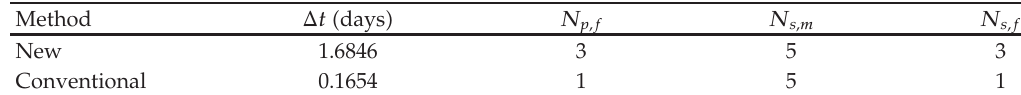
Table 3: Comparison of Example 2.